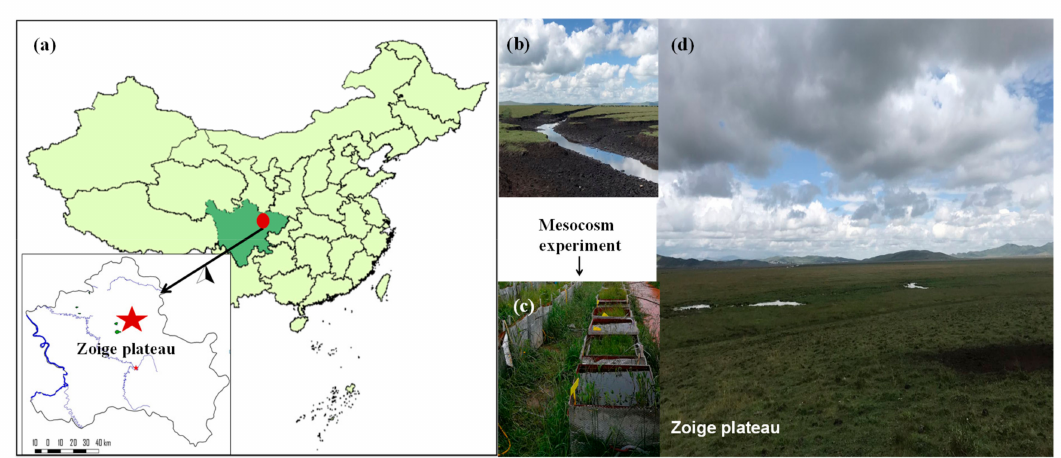
Figure 1. The location of ( a ) the Zoige plateau; ( b ) drainage ditch in a Zoige peatland; ( c ) simulation mesocosms of the experiment; and ( d ) area where the soil blocks and surface vegetation used in mesocosms were